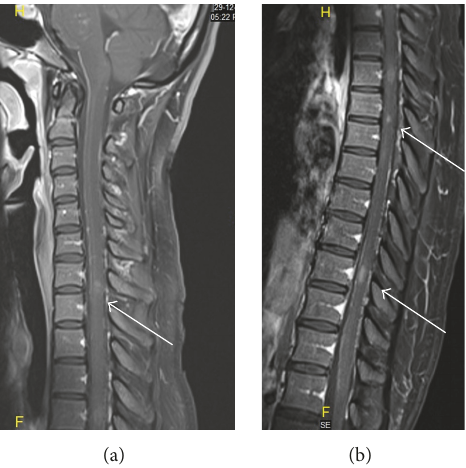
Figure 3: Sagittal T1 weighted MRI after IV gadolinium based contrast medium injection, of the spinal cord, showing multifocal punctate and linear enhancement at cervical and thoracolumbar levels (arrows in (a) and (b)),